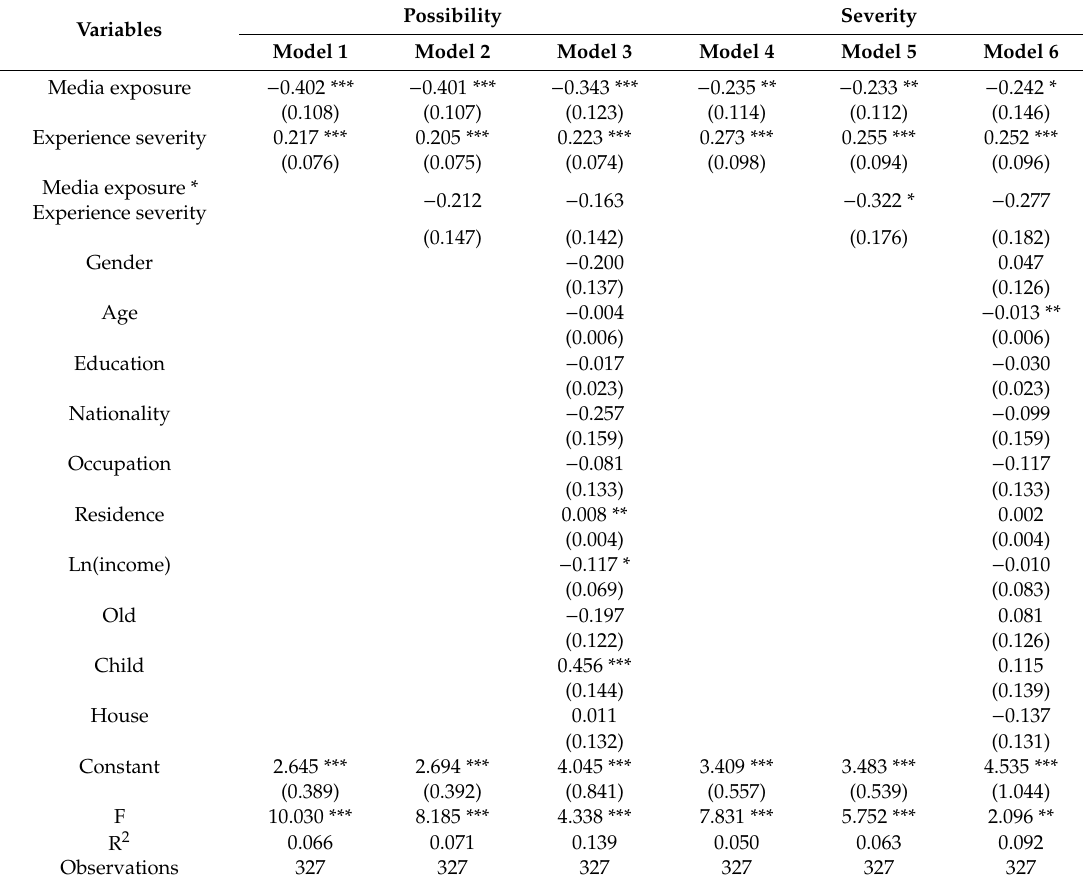
Table 4. Regression analysis results of media exposure, disaster experience and perceived prospect ranks of risk